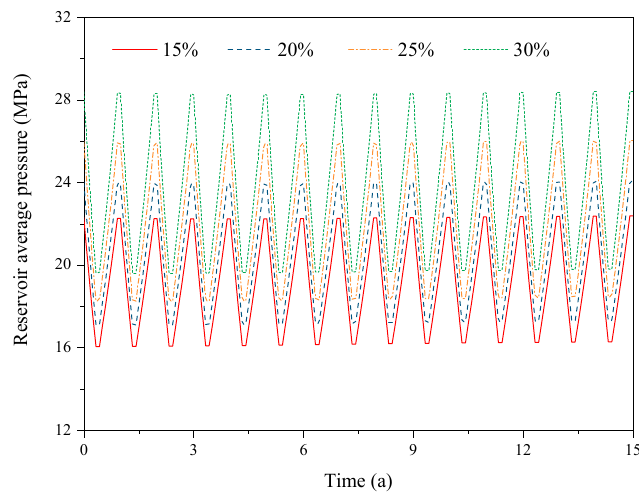
Figure 19. Reservoir average pressure for different residual water saturations.